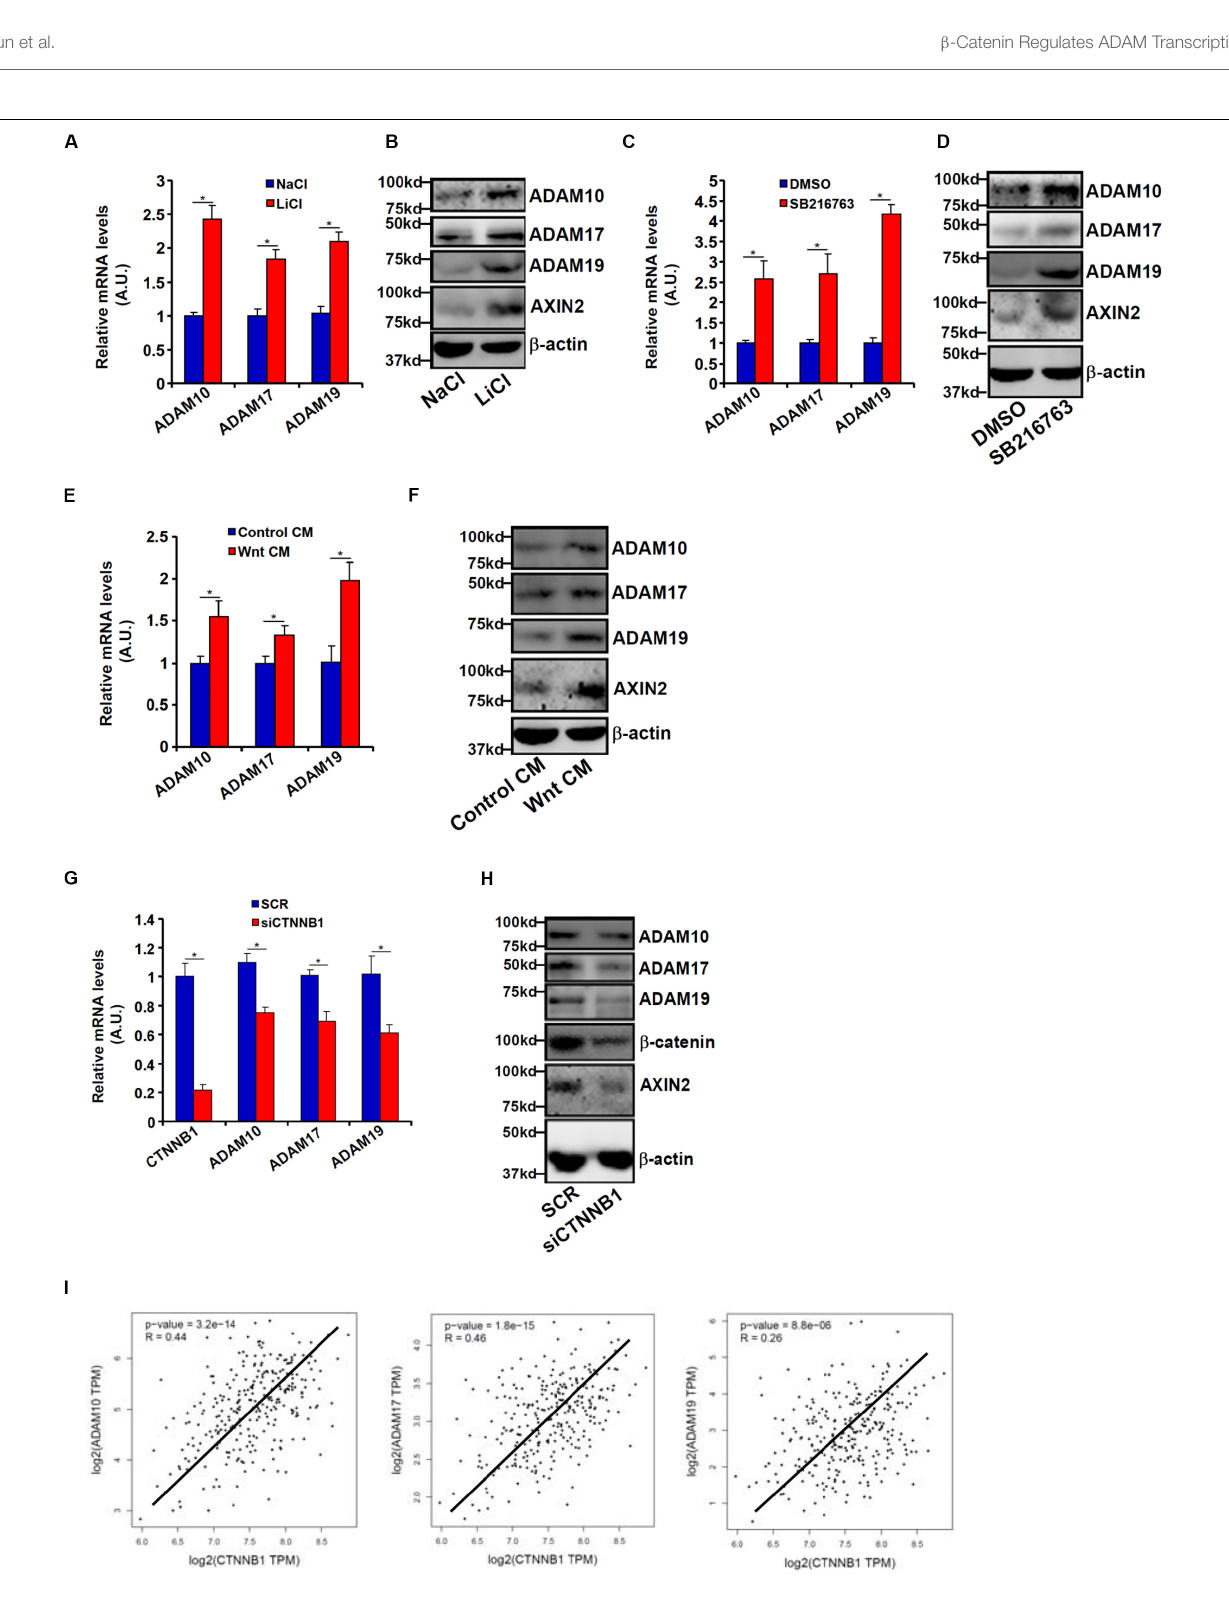
Frontiers in Cell and Developmental Biology |